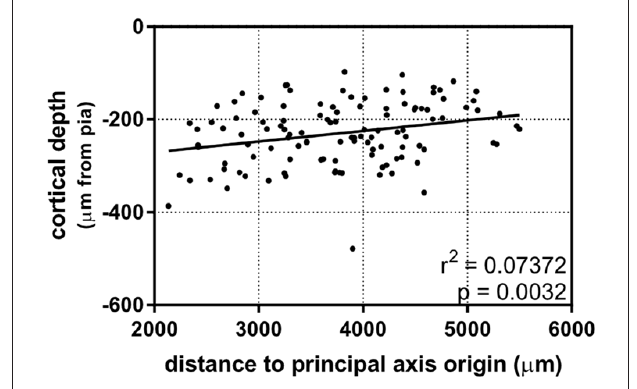
FIGURE 5 | A caudomedial-to-rostrolateral gradient reveals a correlation between laminar positioning and areal position in supragranular neurons born on the same day. Rostrolateral neurons appear to be positioned more superficially when compared to more caudomedial neurons (linear regression). Principal axis and origin is the same as in Figure 4 . N = 116